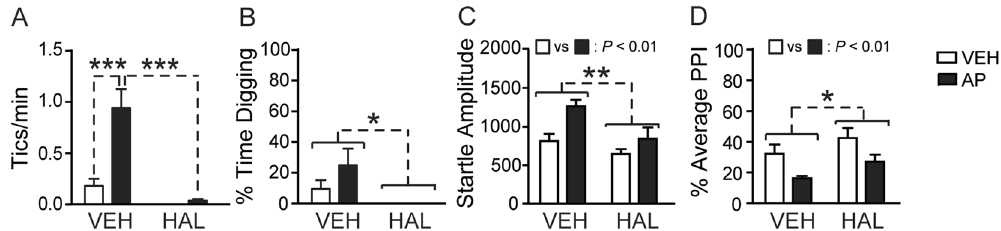
Figure 4. Combined effects of haloperidol (HAL; 0.3 mg/kg, IP) and allopregnanolone (AP; 15 mg/kg, IP) on behavioral phenotypes related to Tourette syndrome in D1CT-7 mice. Data are shown as means ± SEM. ** P < 0.01 and *** P < 0.001 for comparisons indicated by dashed lines. N = 8–9/group. VEH, vehicle; PPI, prepulse inhibition. For further details, see